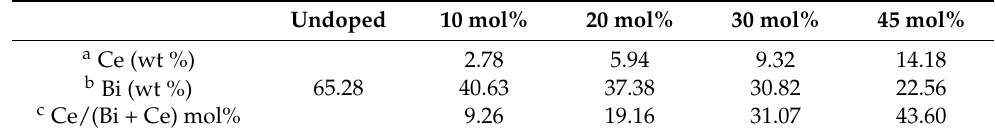
Figure 3. XPS spectra of Cs 3 Bi 2 Cl 9 and Cs 3 Bi 2 Cl 9 : Ce 30% QDs. ( a ) Energy spectrum analysis of Cs element; ( b ) energy spectrum analysis of Cl element; The black line is the experimental data, Dark blue and sky-blue lines are single-peak fitting ( c ) energy spectrum analysis of Bi element; ( d ) energy spectrum analysis of Ce element. The black line is the experimental data, the red line is the fitting of the whole spectrum, and the other color lines are single-peak fitting. Table 2. Actual dopant concentrations obtained by Inductively Coupled Plasma Mass Spectrometry (ICP-MS).